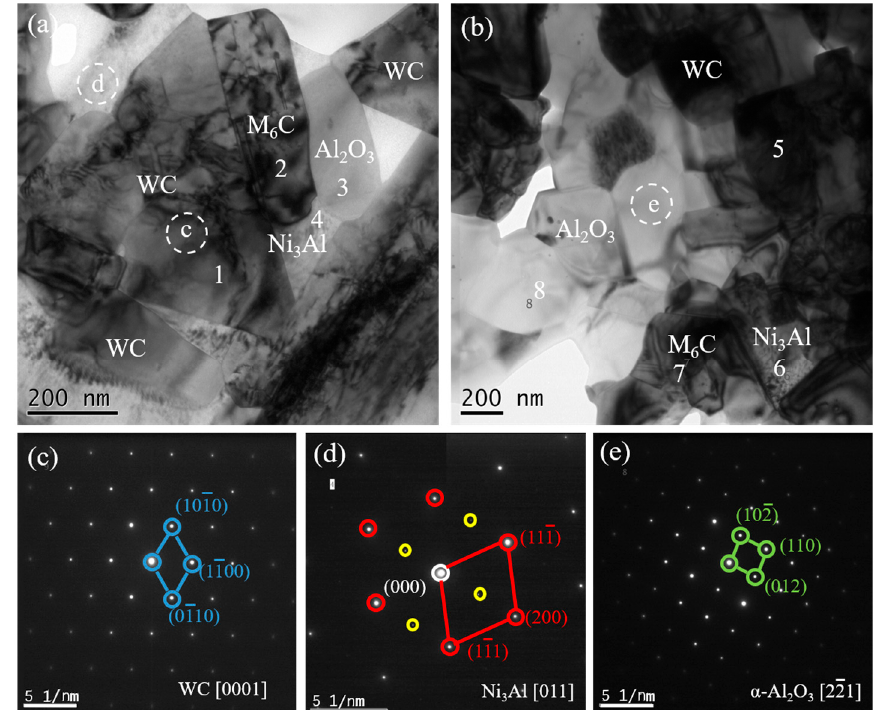
Figure 6. TEM images of the WC-10Ni 3 Al specimen using CH 3 CH 2 OH and selected area electron diffraction patterns obtained from the different phases. ( a ) local area a; ( b ) local area b; ( c – e ) selected area diffraction pattern (SADP) corresponding to the white dotted circles. Table 1. Representative elemental distributions for the WC-10Ni 3 Al specimen made using CH 3 CH 2 OH analyzed by TEM-EDS system (spot size 100 nm). Elements Spot